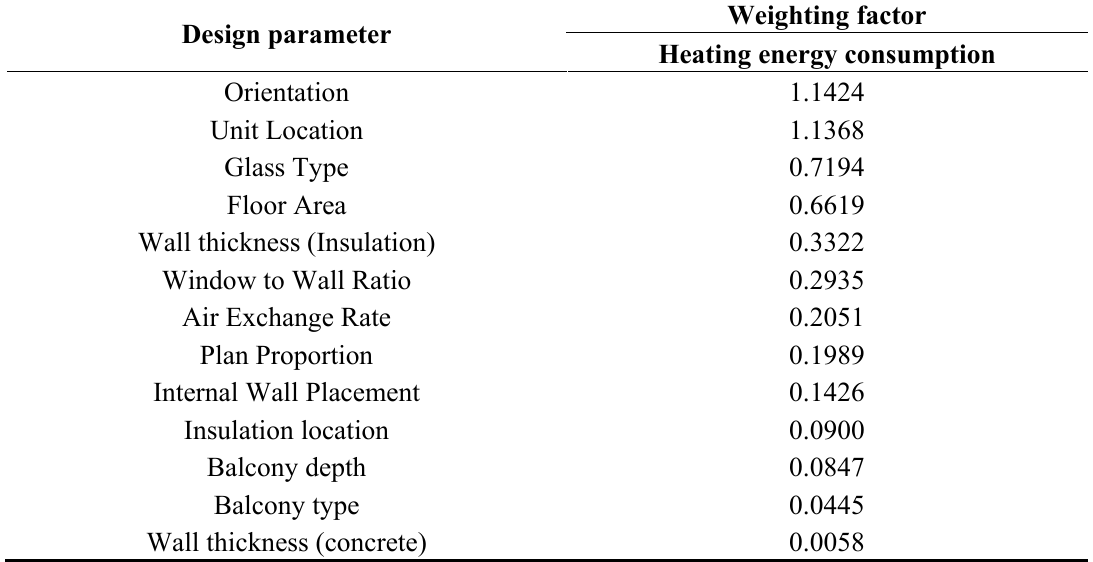
Table 8. Weighting factor for heating energy